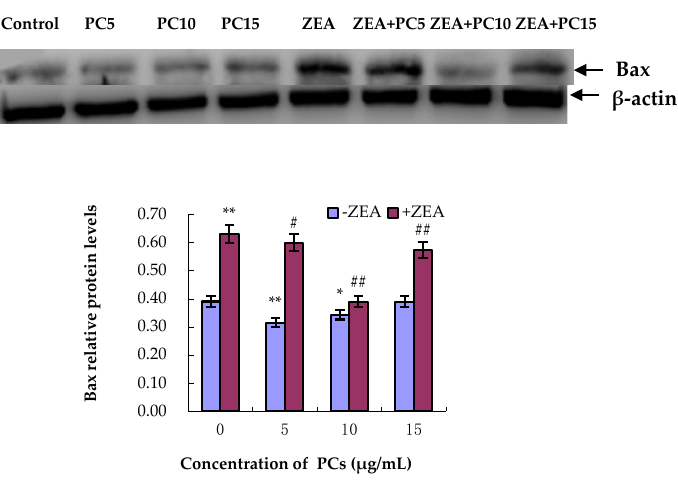
Figure 11. Effects of different concentrations of proanthocyanidins (PCs) on zearalenone (ZEA)-induced relative expression of Bax protein in MODE-K cells. The relative expression of Bax protein increased when cells were exposed to ZEA, while the expression did not increase when cells were treated with PCs. The expression decreased when cells were co-treated with PCs/ZEA. * p < 0.05 and ** p < 0.01 vs. control group; # p < 0.05 and ## p < 0.01 vs. ZEA-treated group.